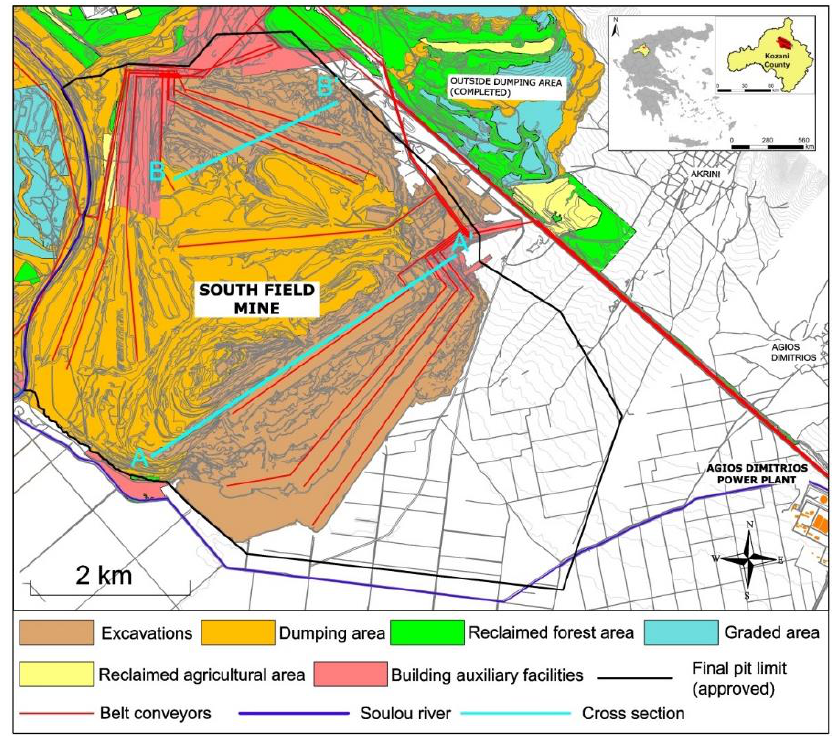
Figure 1. South Field Mine and relative land use. Location of cross-sections (A –A’ and B–B’) . Gray to yellow clastic sediments: This group consists of clay, sandstones, sand, con- glomerates, and siltstones. The average thickness of the whole formation is 25 m, while the average thickness of the hard material is 11 m. Green-gray clay, sand, and silt sediments: The thickness of this formation varies from 25 m to 50 m. No hard material has been found in this formation. The extent and the distribution of hard and semi-hard formations in the overburden strata are presented in the geological section of Figure 2.